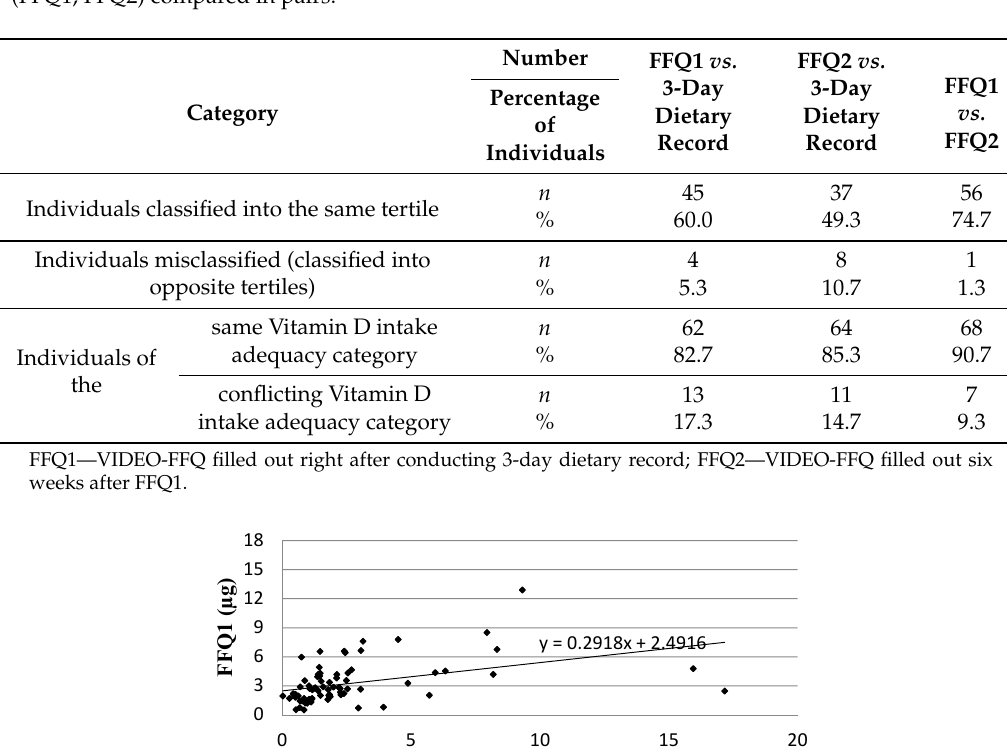
Table 4. The numbers and percentages of individuals classified into the same tertile and misclassified, accompanied by the numbers and percentages of individuals from the same or conflicting Vitamin D intake adequacy category presented for three ‐ day dietary record and VIDEO ‐ FFQ conducted twice (FFQ1, FFQ2) compared in pairs.